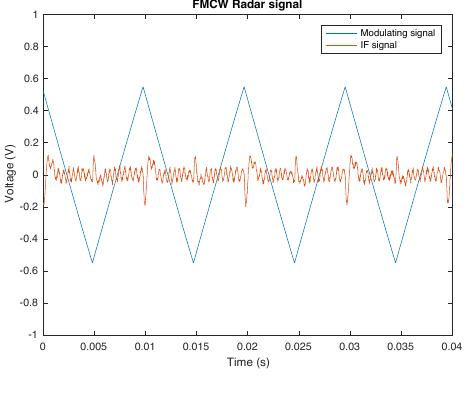
Figure 1. FMCW Radar